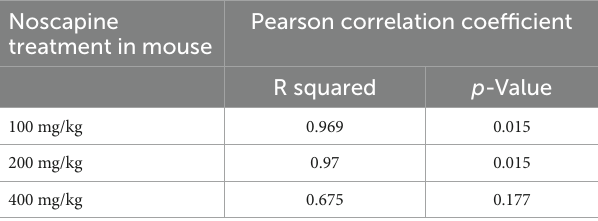
TABLE 3 Correlation of noscapine levels in plasma and brain of noscapine treated mouse. Noscapine treatment in